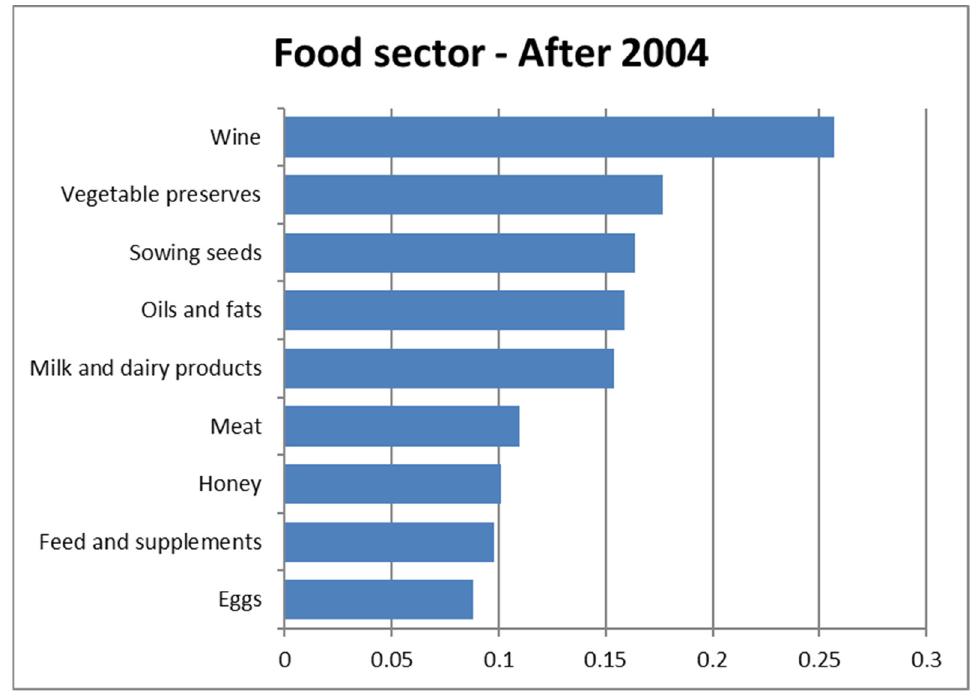
Figure 4. Ranking of food sectors after 2004.